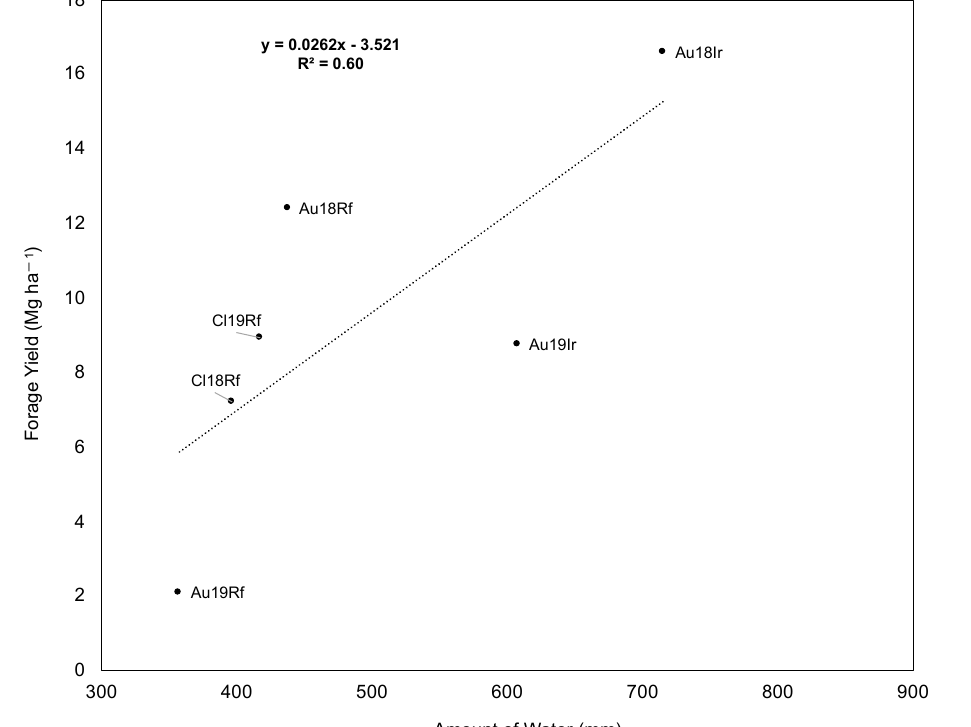
Figure 5. Relationship between annual forage yield evaluated in Mediterranean environments of Chile and Australia and amount of water (rainfall or rainfall + irrigation) added to the experimental plots. Environments were rainfed experiment in Australia in 2018 (Au18Rf) and 2019 (Au19Rf) growing seasons, irrigated experiment in Australia in 2018 (Au18Ir) and 2019 (Au19Ir) growing seasons, and rainfed experiment in Chile in 2018 and 2019 growing season (Cl18Rf and Cl19Rf).